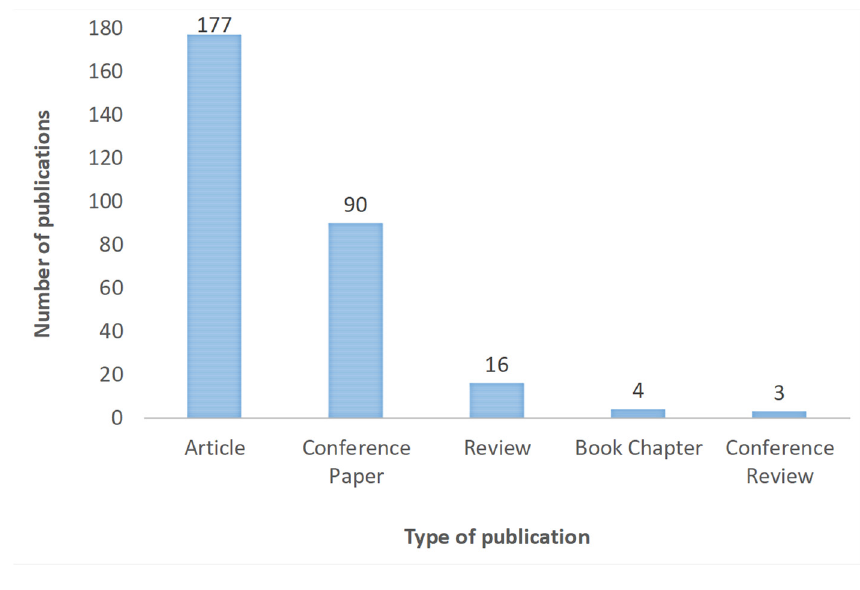
Figure 1. Type of publication.